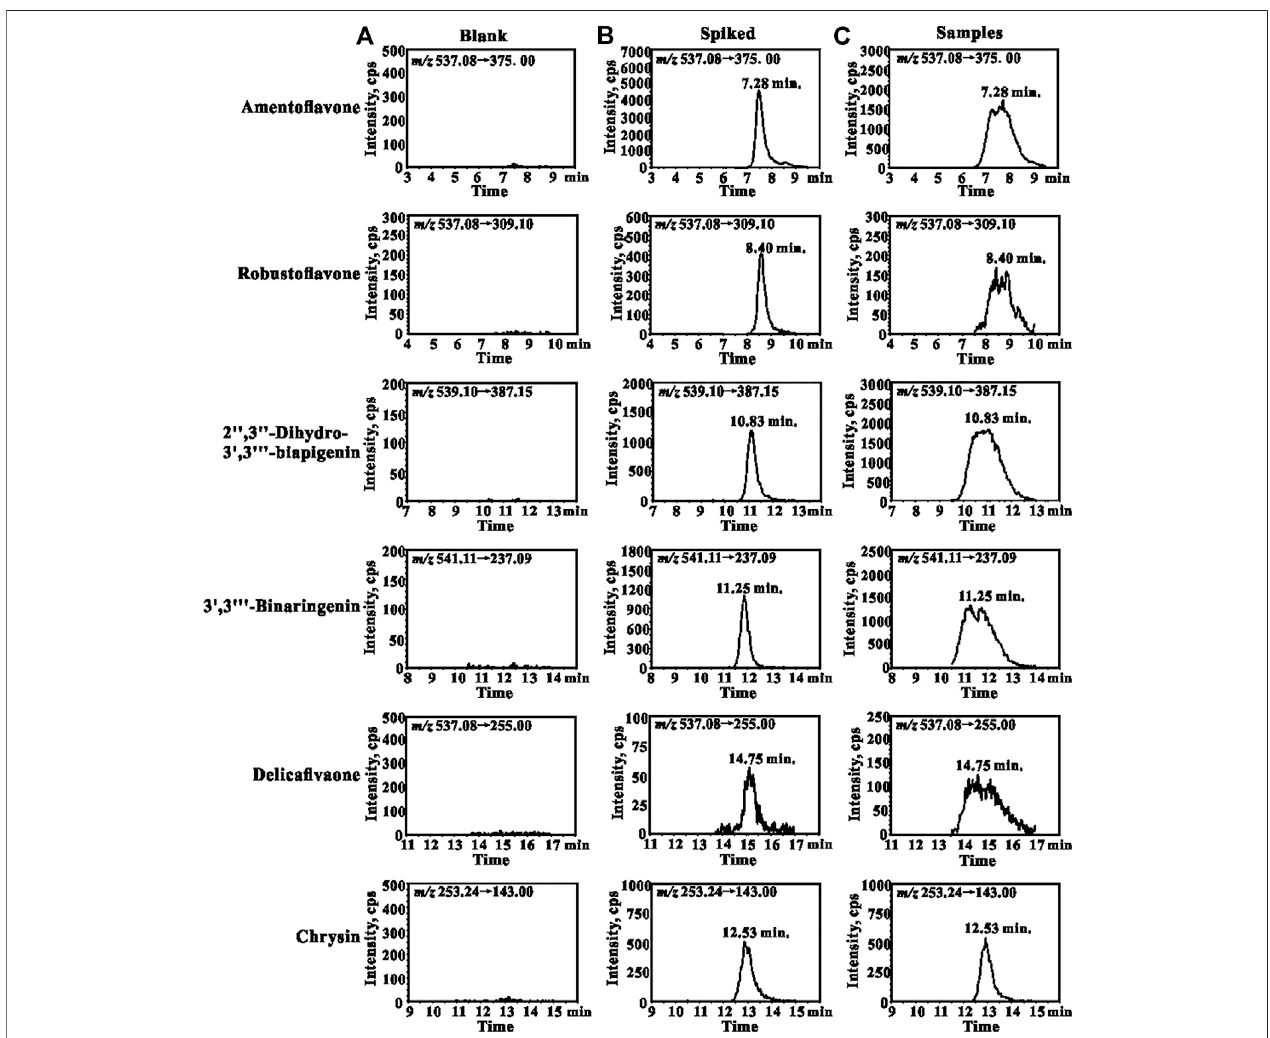
FIGURE 1 | Representative MRM chromatograms for amento fl avone, robusta fl avone, 2 ″ ,3 ″ -dihydro-3 ′ ,3 ‴ -biapigenin, 3 ′ ,3 ‴ -binaringenin, delica fl avone, and chrysin(IS): (A) blank lungs sample; (B) blank lungs spikedwithQCM and IS(50 ng/ml); (C) lungs samplecollectedfrom the rat5 min after oraladministration ofTBESD at a dose of 600 mg/kg.